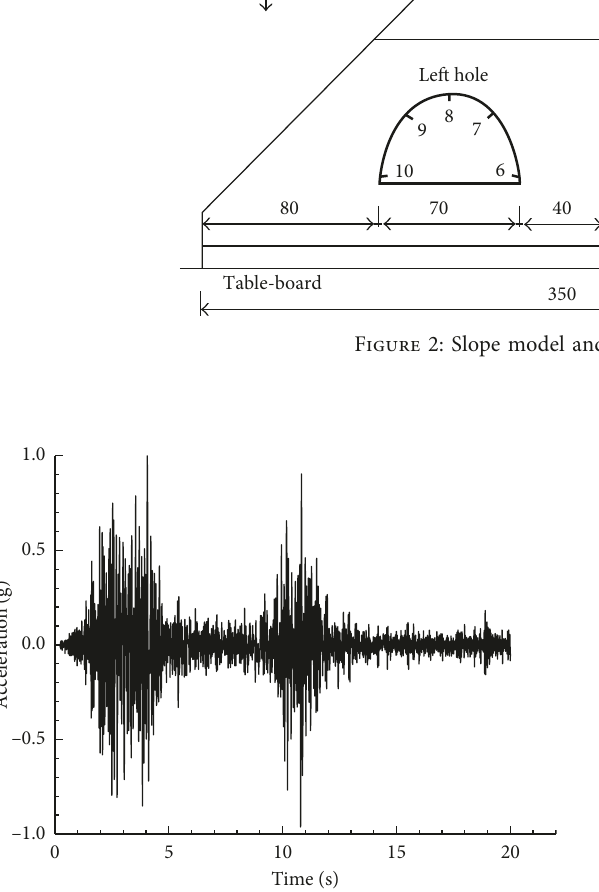
Figure 3: Acceleration time-history of Wenchuan seismic wave.